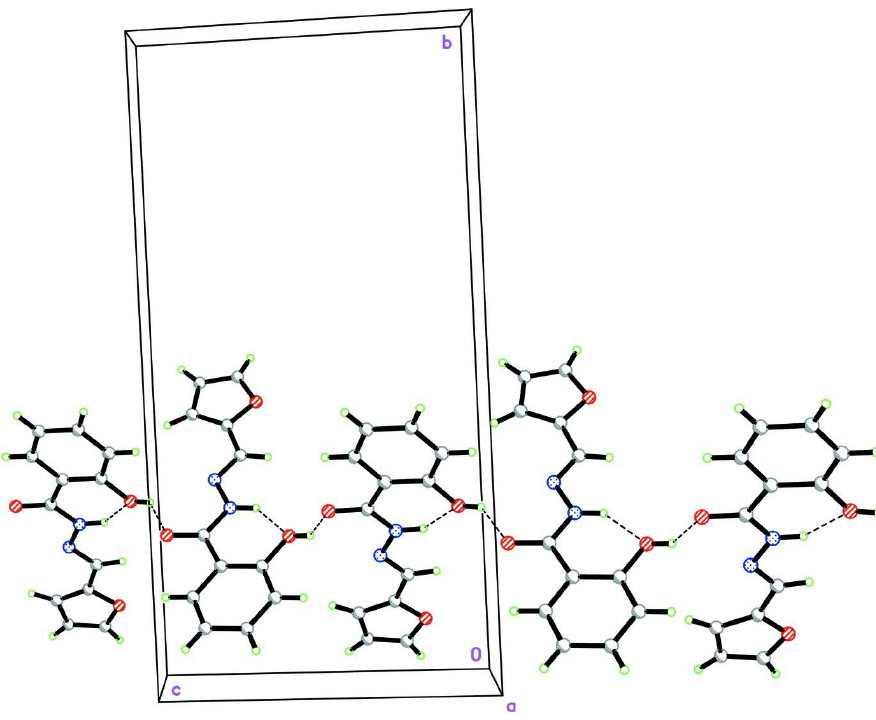
Figure 2 The structure of the infinite chains formed via hydrogen bonds, H atoms have been omitted for clarity. Dashed lines indicate hydrogen